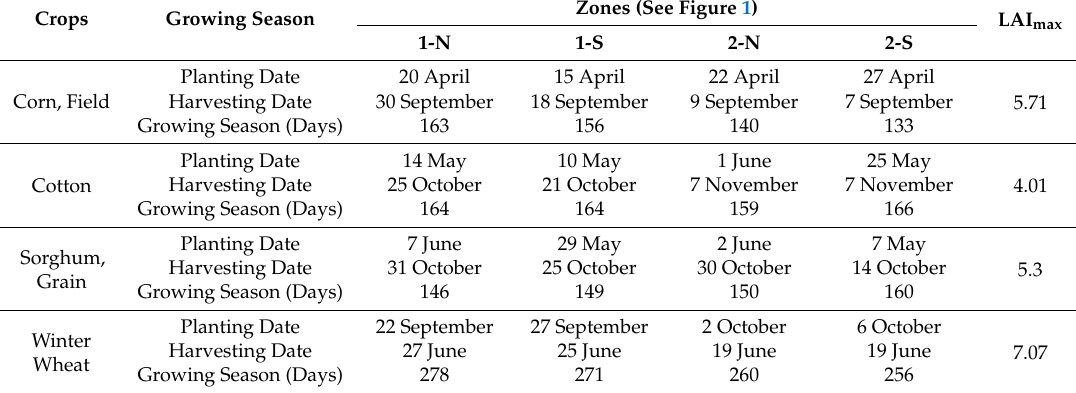
Table 2. Growing season timeline of corn, cotton, sorghum grain, and winter wheat crops